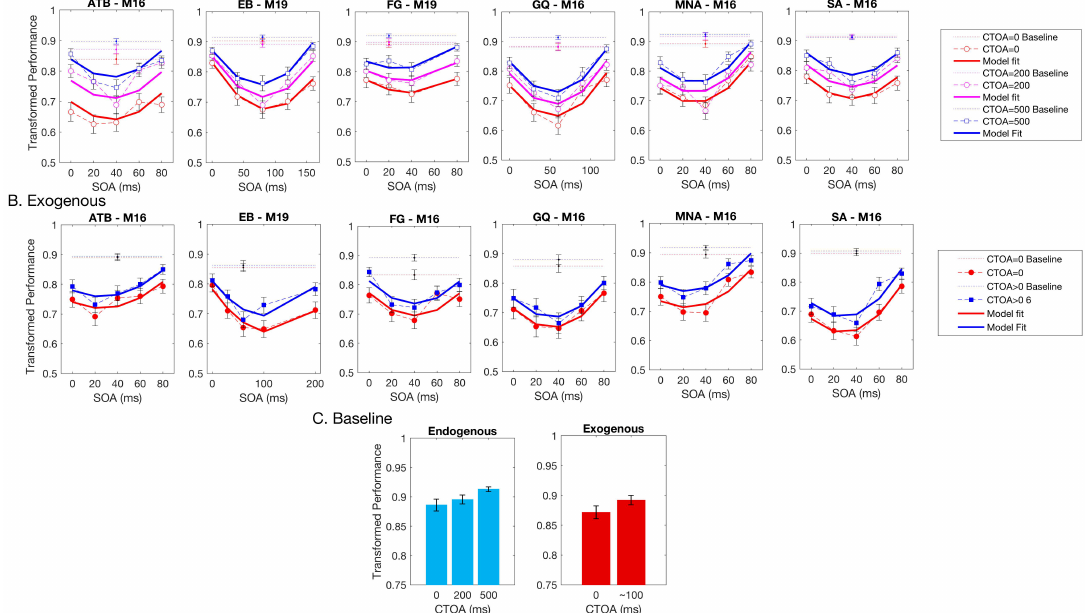
Figure 3. The transformed performance in the ( A ) endogenous and ( B ) exogenous attention conditions for all CTOAs and SOAs. The horizontal axes represent SOA and the vertical axes represent transformed performance (see Methods, Section 2). Different colors represent different CTOA conditions. The dotted horizontal lines indicate baseline (i.e., without masks) performance. The markers and the dashed lines represent empirical data, whereas the solid lines show the best-fit regression model. Each panel shows data from a single observer. The initials of each observer and the best regression model (see Table 2) are given on top of each panel. Error bars represent ± SEM across trials (n = 100). Note that only the validly cued trials are included in both conditions, which correspond to 100% and 25% of the trials in the endogenous and exogenous attention conditions, respectively. Results of invalidly cued trials in exogenous attention condition is shown in Appendix A. ( C ) The baseline performance (averaged across observers) as a function of CTOA in both conditions. Error bars represent ± SEM across observers (n =